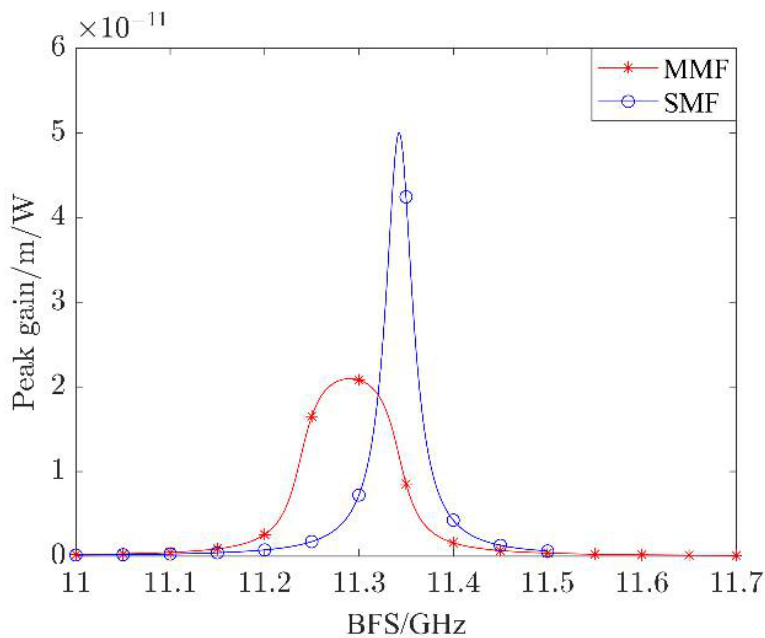
Figure 1. Brillouin gain spectra of MMF and SMF.